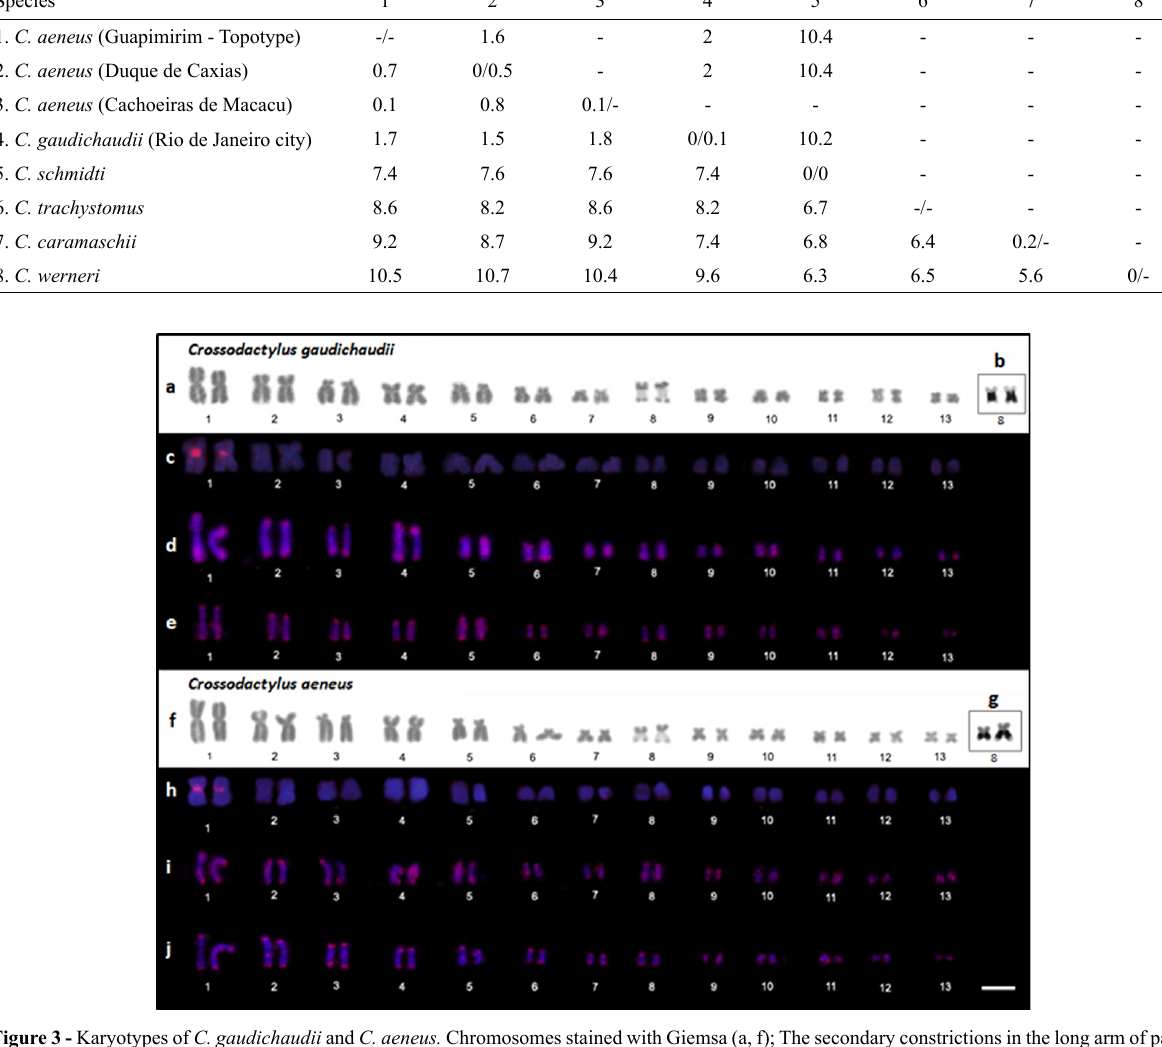
Figure 3 - Karyotypes of C. gaudichaudii and C. aeneus. Chromosomes stained with Giemsa (a, f); The secondary constrictions in the long arm of pair 8 coincide with the NOR, which were silver-impregnated by the Ag-NOR method, as shown in insets b and g. Dark planks show chromosome hybridized with probes for the PcP190 satellite DNA (c, h), (CA) microsatellite repeat (d,i), and (GATA) microsatellite repeat in (e,j). Bar = 10 15 8